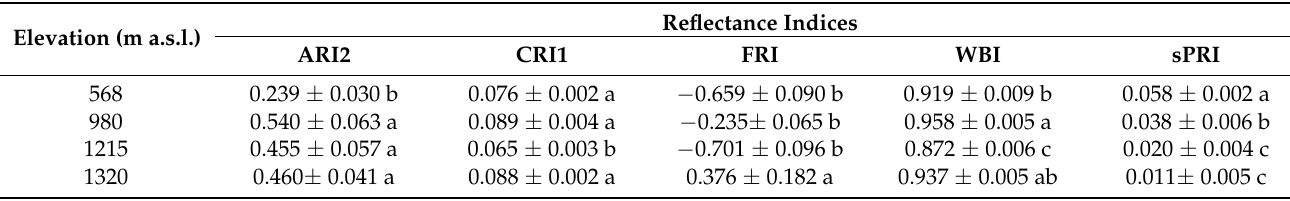
Table 4. Spectral reflectance indices for green alder (Alnus viridis ) leaves growing in the Bieszczady Mts. at various elevations a.s.l. Elevation (m